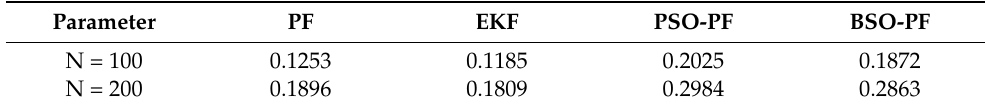
Table 1. Operation time